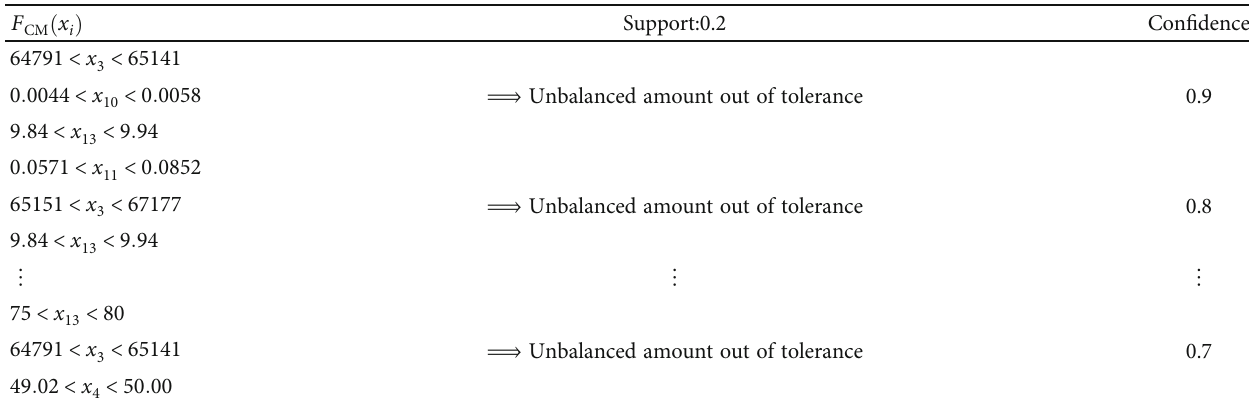
Table 20: Strong association rules when the imbalance is out of